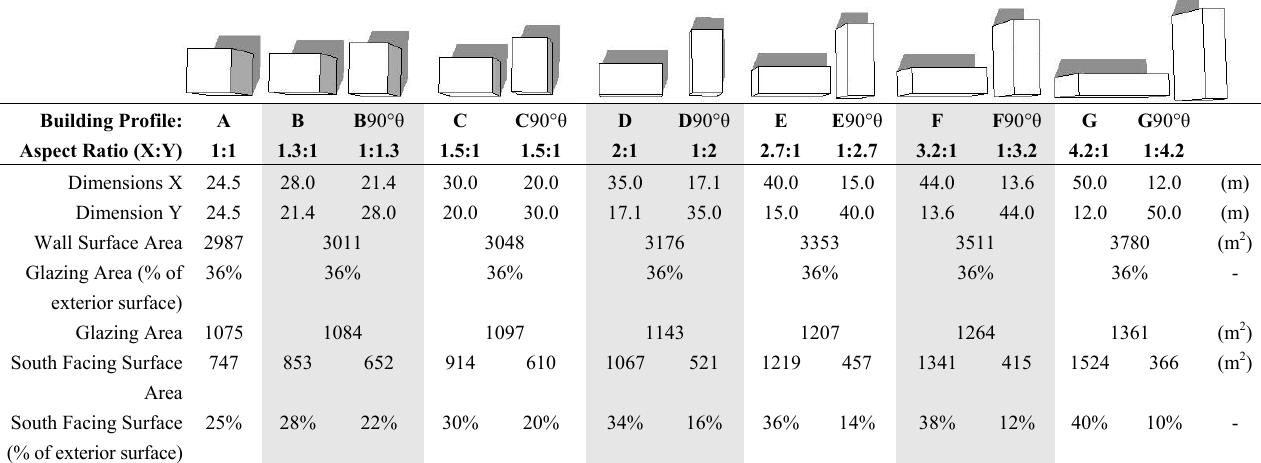
Table 1. Model simulation